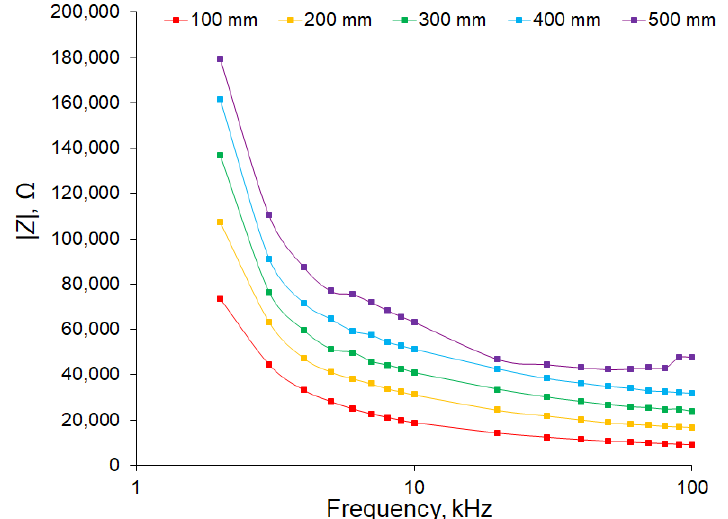
Figure 9. Dependence of the impedance modulus on frequency for different sample lengths after compensating for the capacitive transition of the electrodes. The apple tree was 23 mm in diameter. The number of samples in each experimental group was 5 and the number of measurement repetitions was 5. Data are presented as mean values.